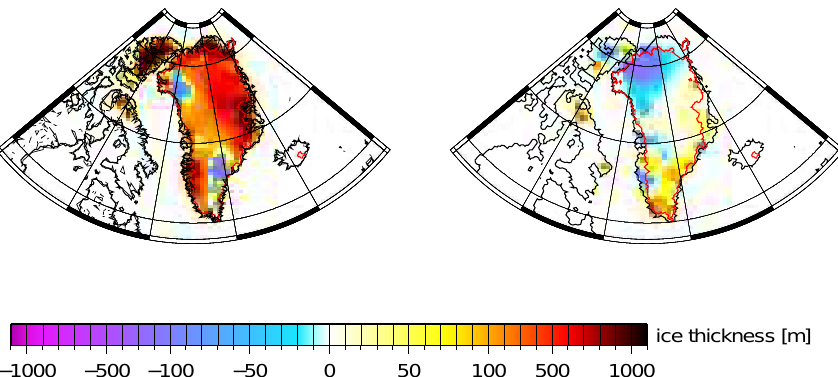
Figure 10. Difference between the observed and the calculated ice-sheet thickness in the SNOW experiment (a) – (SNOW-observed) in m and between the SNOW and the PRECIP experiment (b) (PRECIP-SNOW). The red contour line corresponds to the observed present-day ice